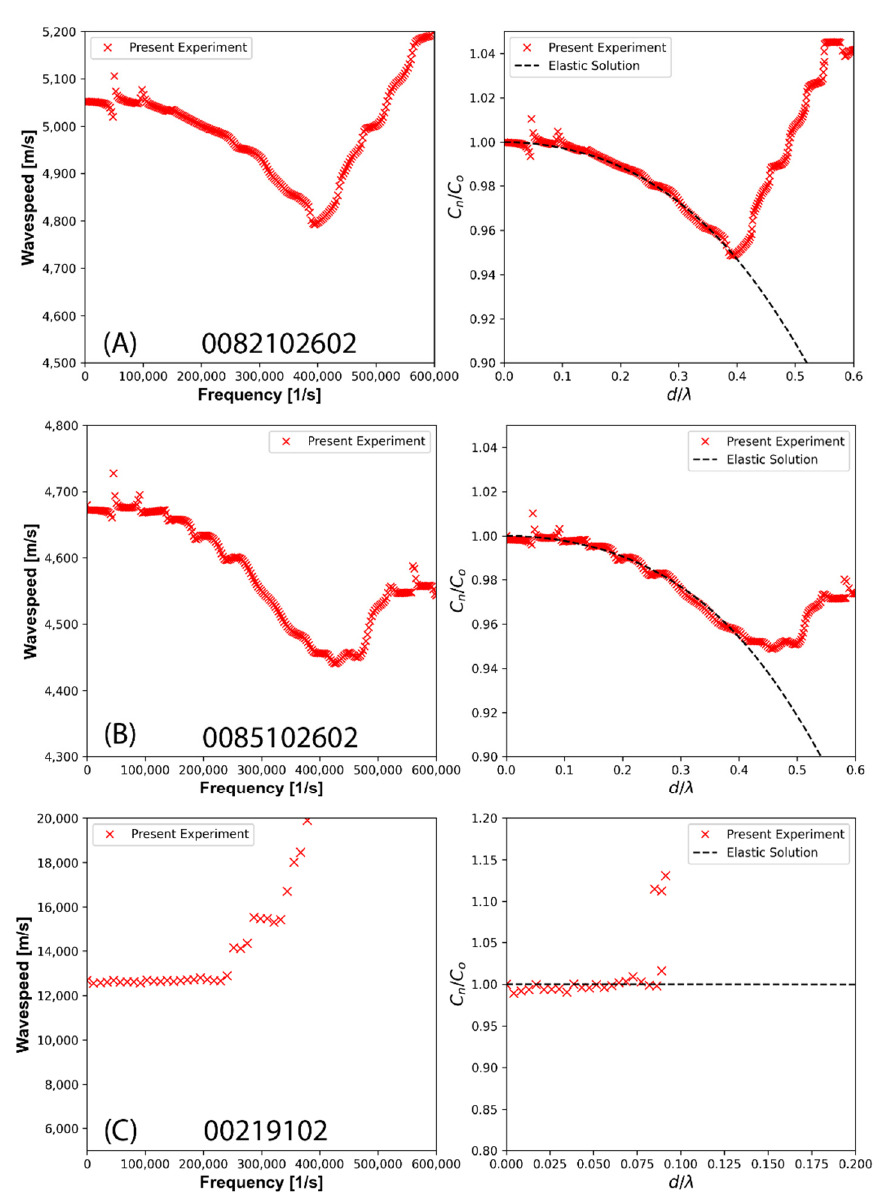
Figure 5. The characteristic wavespeed versus frequency, and ratio of wavespeed by the speed of the fundamental frequency ( C n / C o ) versus the ratio of bar diameter by wavelength ( d / λ ) for ( A ) 7075-T6 aluminum (0082102602), ( B ) C350 maraging steel (0085102602), ( C ) S200F beryllium (00219102) experiments. The plot shows no frequency dependence of the wavespeed for the range of resolvable frequencies for the beryllium Kolsky